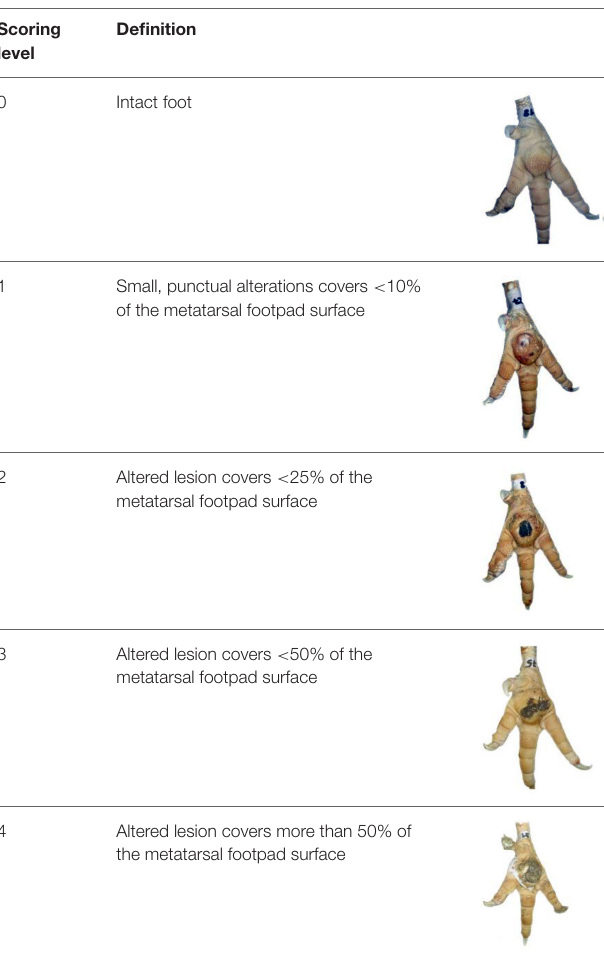
TABLE 1 | Scoring system for footpad dermatitis (FPD) on the metatarsal footpad adapted from Hocking et al.